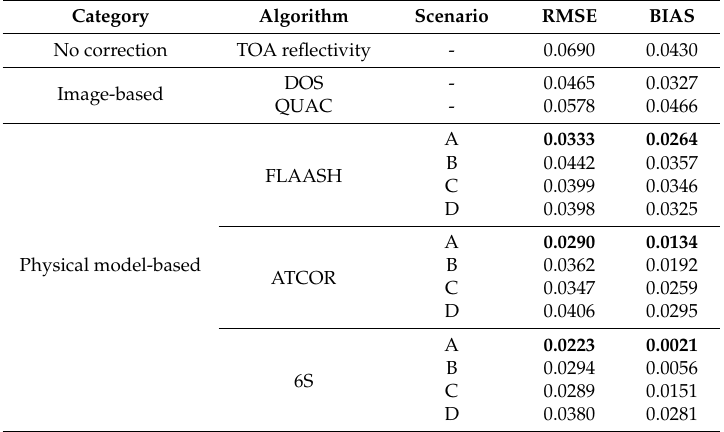
Table 2. RMSE and BIAS between the in-situ measurements and satellite corrected reflectance for each atmospheric